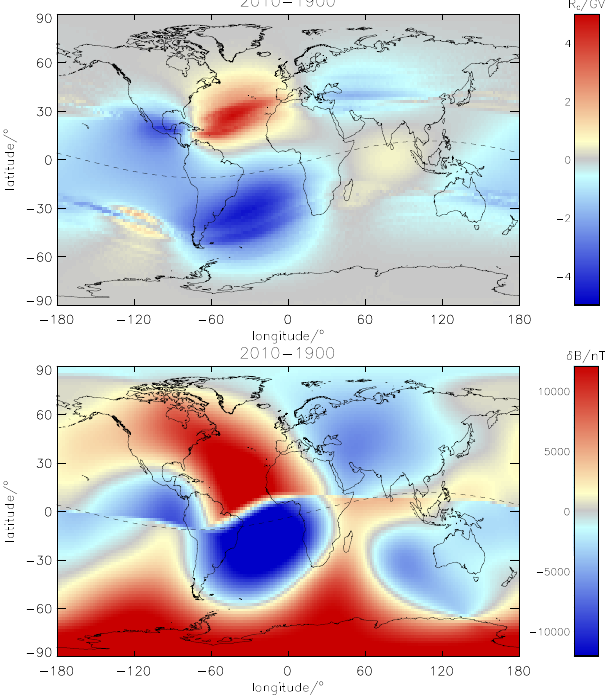
Fig. 3. The absolute differences of R C (upper panel) and δB (lower panel) between 1900 and